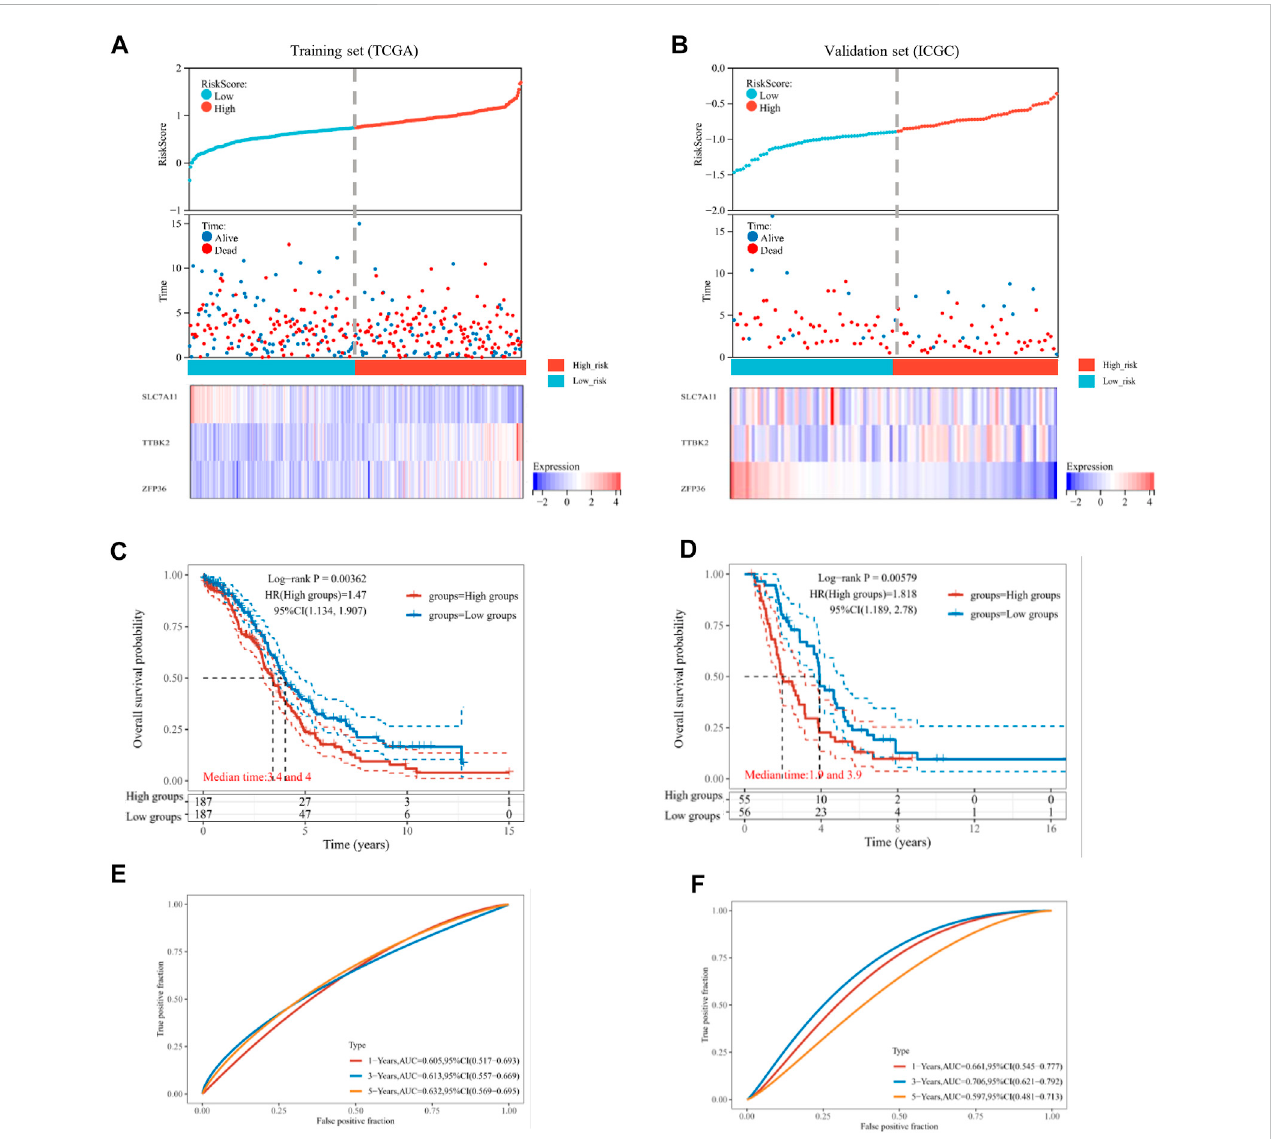
FIGURE 3 Estimation of prognostic signature based on ferroptosis-related genes (FRGs). The distribution of risk score, survival time, and survival status for each ovarian cancer (OV) patient in the training set (A) and validation set (B) . The scatter plot distribution represented the risk score of different samples corresponding to the survival time and status (top and middle). The heatmap is the gene expression of the three-gene signature (bottom). The Kaplan-Meier (K-M)curvesforpatientoverallsurvival(OS)inthehigh-riskgroupandlow-riskgroupofthetrainingset (C) andvalidationset (D) .TheROCanalysisofthe training set (E) and validation set (F) for OS prediction by the three-gene